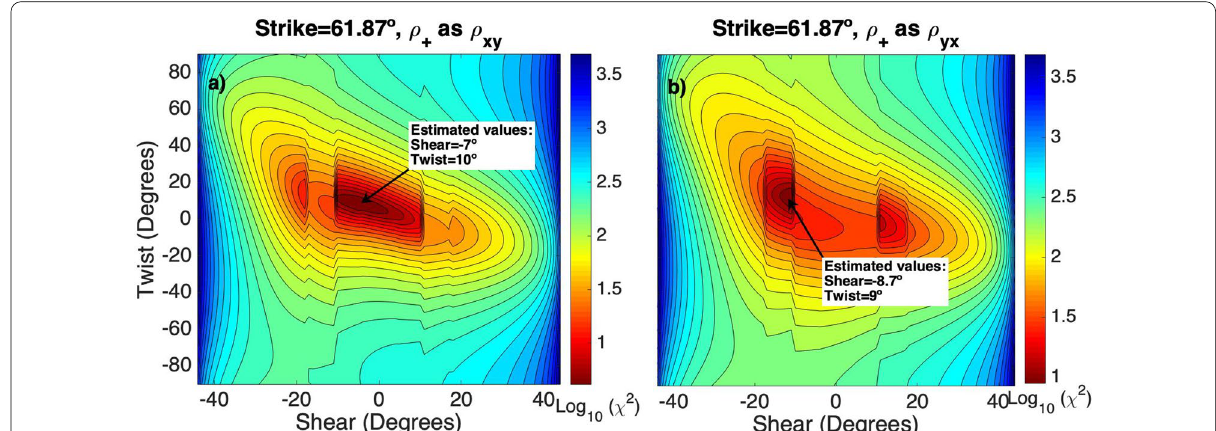
as Z xy with a smaller misfit. b Strike of 61.87º and Z +